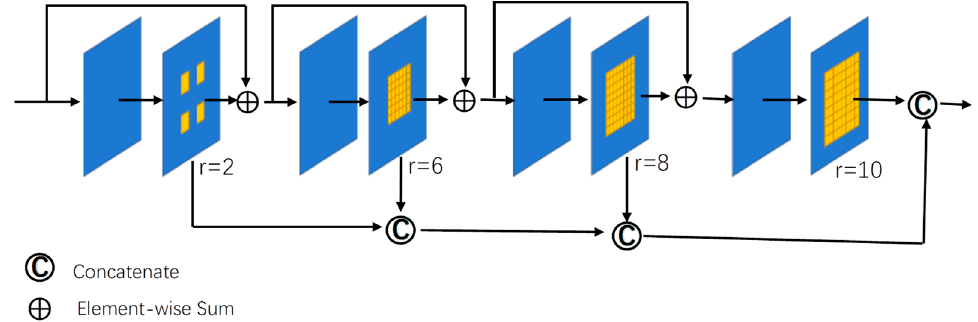
Figure 5. The detailed structure of MSFM.